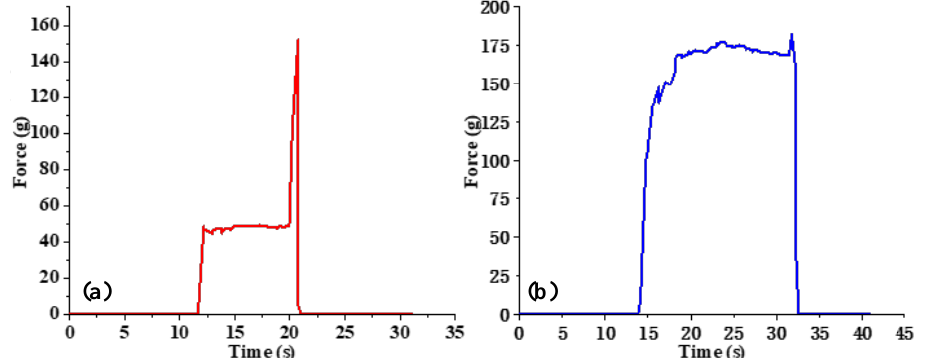
Figure 9. Slippage detection based on force signal. ( a ) The target object is stably placed on the target sensor. ( b ) The target object slides away from the pressure sensor.